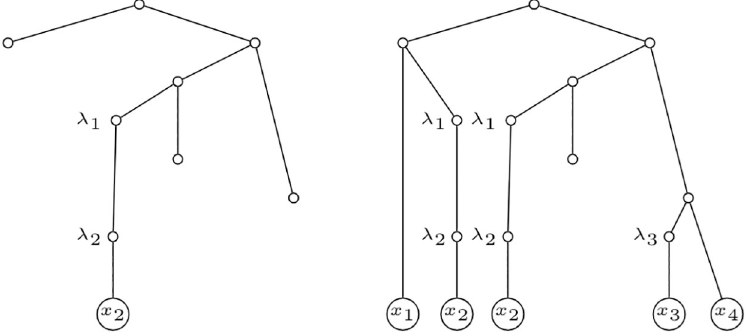
Fig 3. Two primary subtrees of U ( N ). Let N be the IMLN depicted in Fig 1. The figure depicts two primary subtrees of U ( N ) corresponding to the terms λ 1 λ 2 x 2 y 3 (left), and l 2